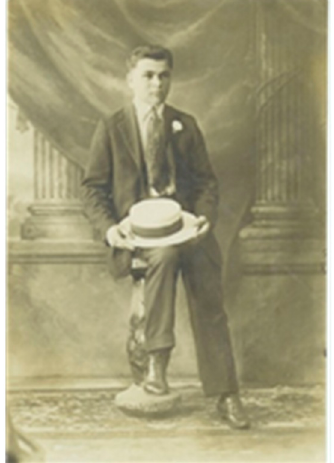
Figure 1. Mitsos’ first portrait in New York (courtesy of Victoria P).